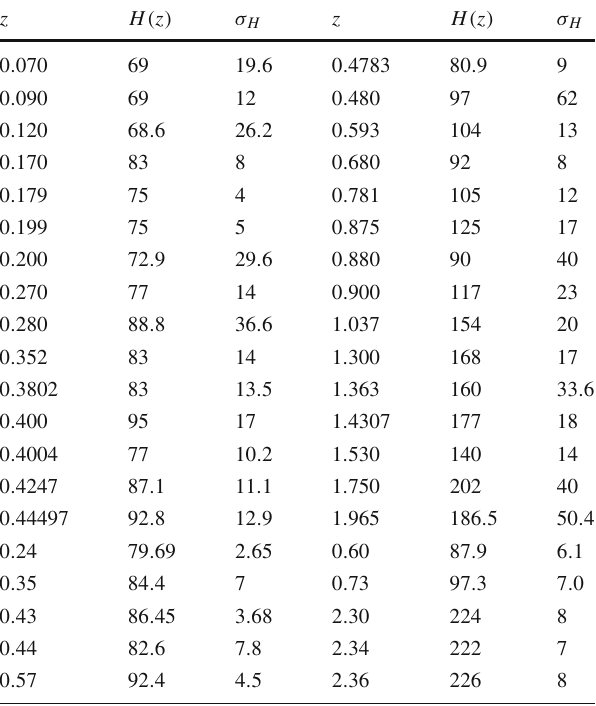
Table 1 H ( z ) and its uncertainty σ H are in units of km s − 1 Mpc − 1 . The upper panel depicts 30 samples deduced from the differential age method. The lower panel, 10 samples obtained from the radial BAO method. The table is built according to [4] (see also references therein for details) z H ( z